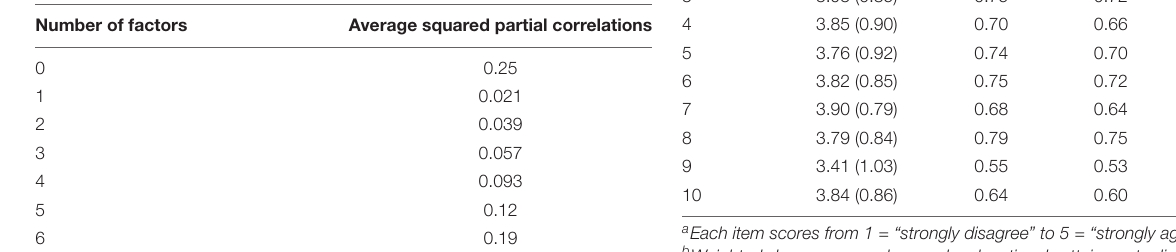
a Each item scores from 1 = “strongly disagree” to 5 = “strongly agree.” b Weighted by age, gender, and educational attainment distribution of the Hong Kong general population. c Proportion of total variance =